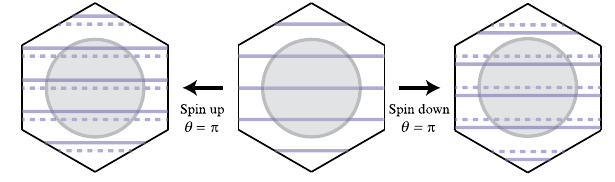
FIG. 2. The effect of flux insertion on the mixed-space model is to shift the allowed momentum cuts through the Brillouin zone. down electrons, thus preserving time-reversal symmetry. Note that for θ ¼ 4 π n for any integer n , the cuts are again in their original positions.